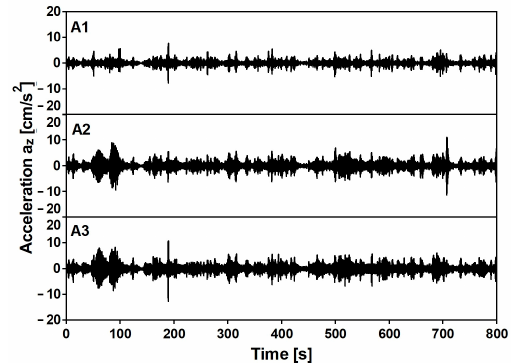
Figure 13. Acceleration [cm/s 2 ] time histories at A1, A2 and A3 stations for vertical direction.